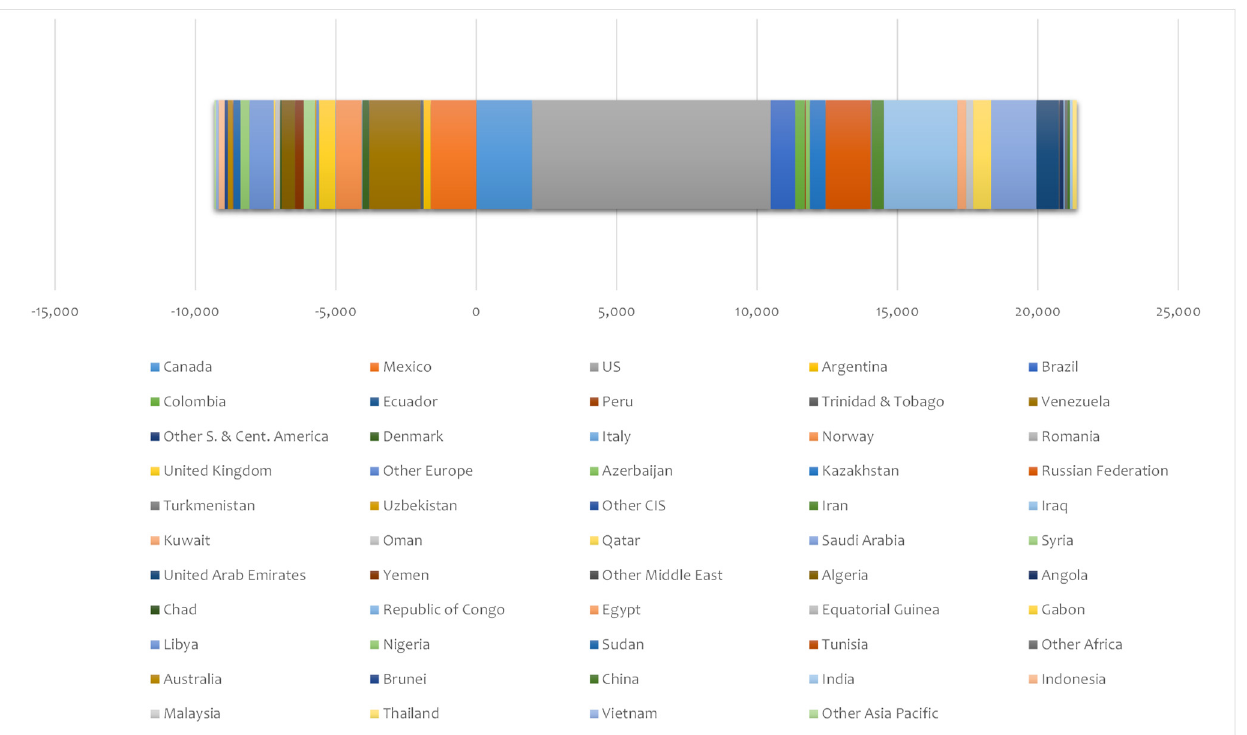
Figure 8. Changes in global oil production by country in 2006–2018 (data were collected from [22]).